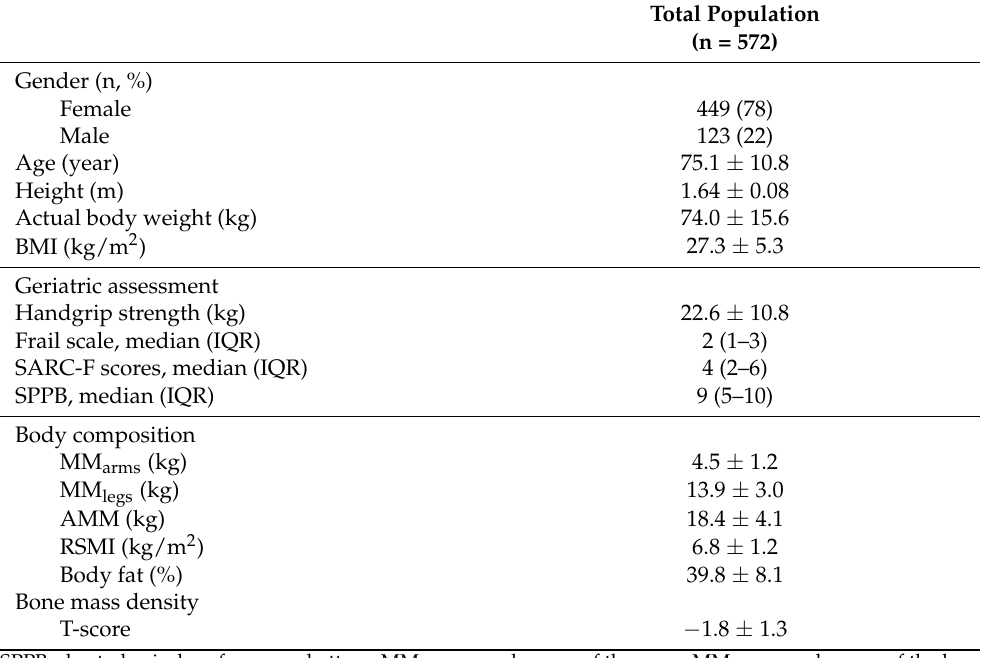
Table 1. Characteristic of study